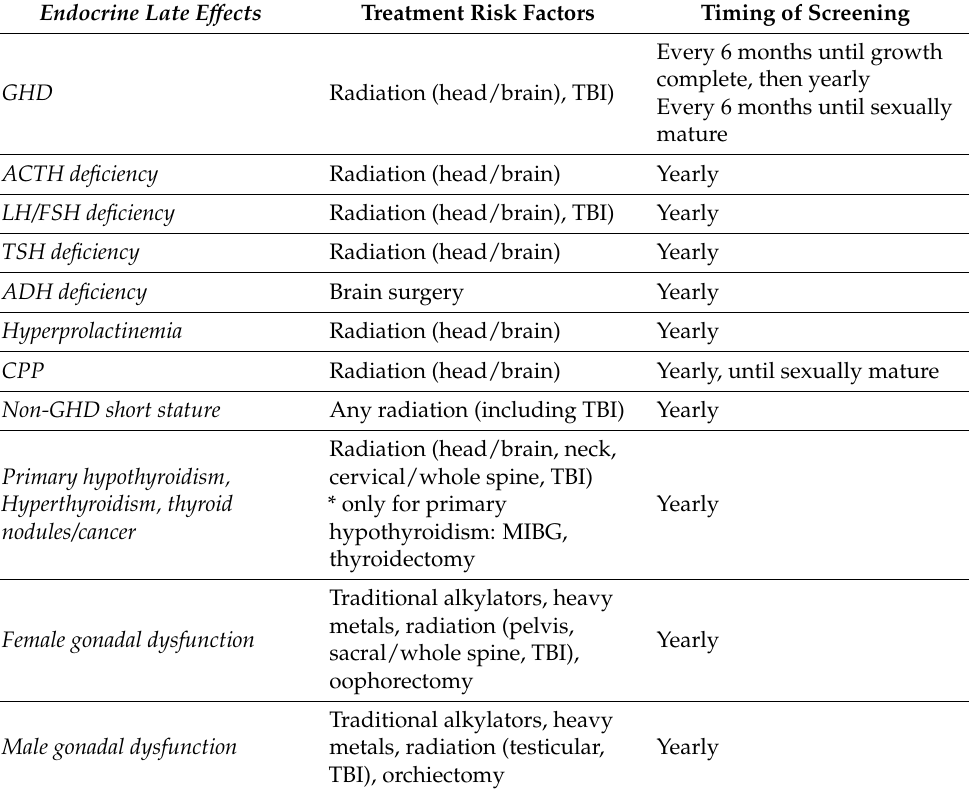
Table 1. Endocrine late effects due to risk factors related to cancer treatment per Children’s Oncology Group